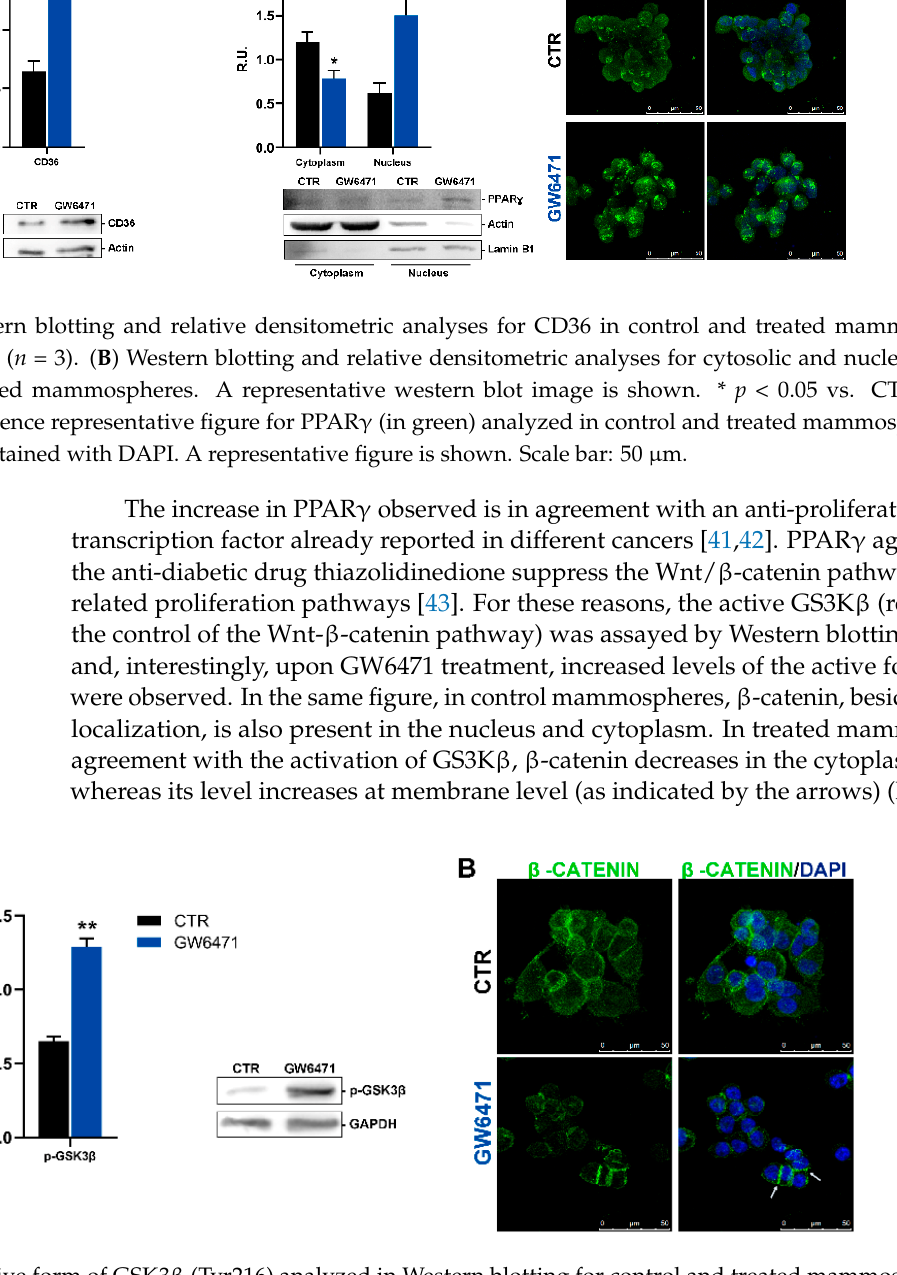
Figure 6. ( A ) the active form of GSK3 β (Tyr216) analyzed in Western blotting for control and treated mammospheres. A representative western blot image is shown. ** p < 0.005 vs. CTR ( n = 3). ( B ) Immunofluorescence representative figure for β -catenin (green). In blue, the nuclei are stained with DAPI. The arrows indicate the localization at the membrane level. Scale bar: 50 µm.